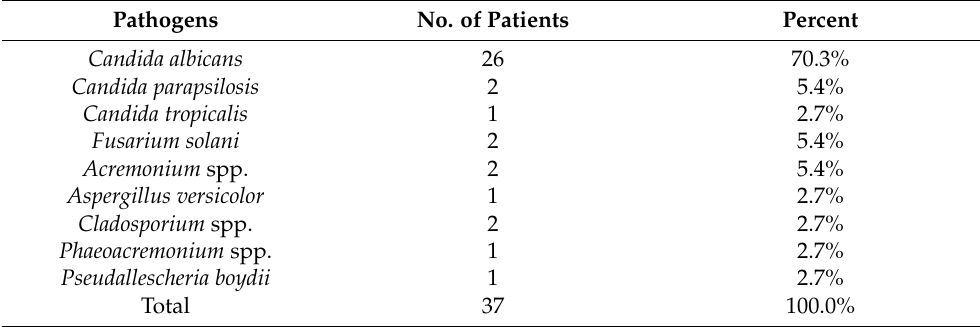
Table 2. Pathogens of Exogenous Fungal Endophthalmitis.